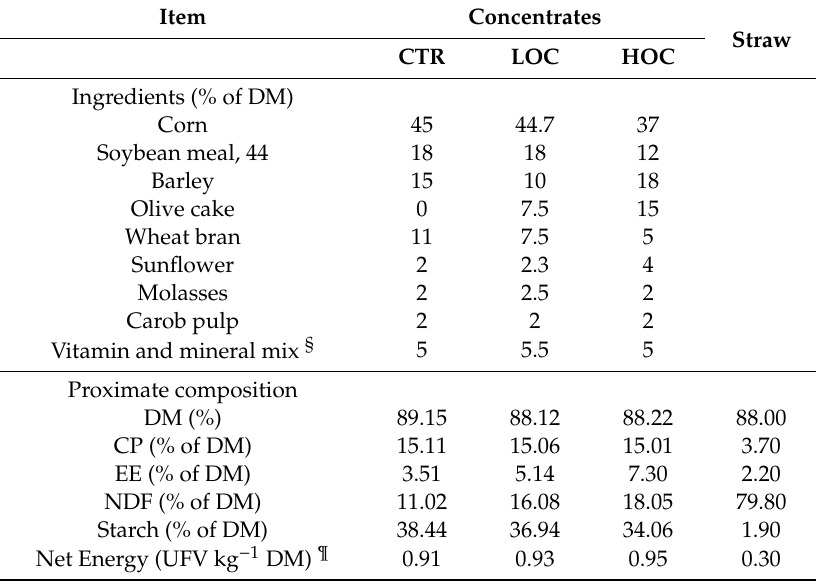
Table 1. Ingredients and proximate composition of the concentrates and straw. Item